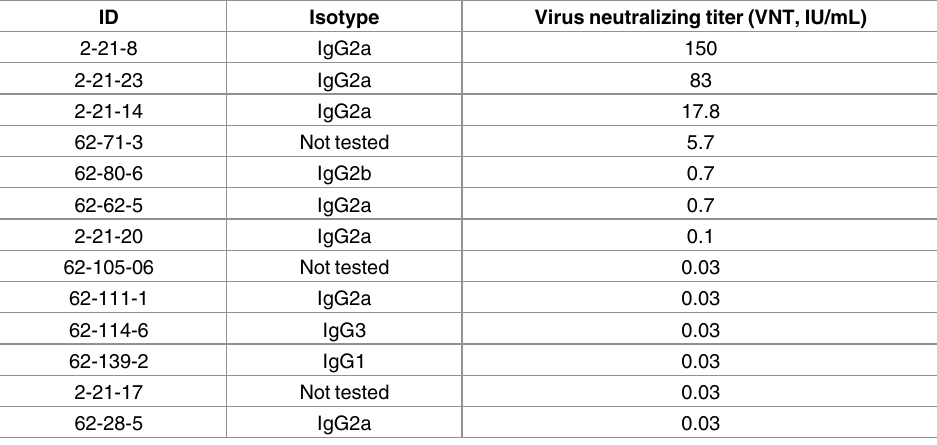
Table 1. Supernatant neutralizing activity of each hybridoma clone against CVS-11 virus. ID